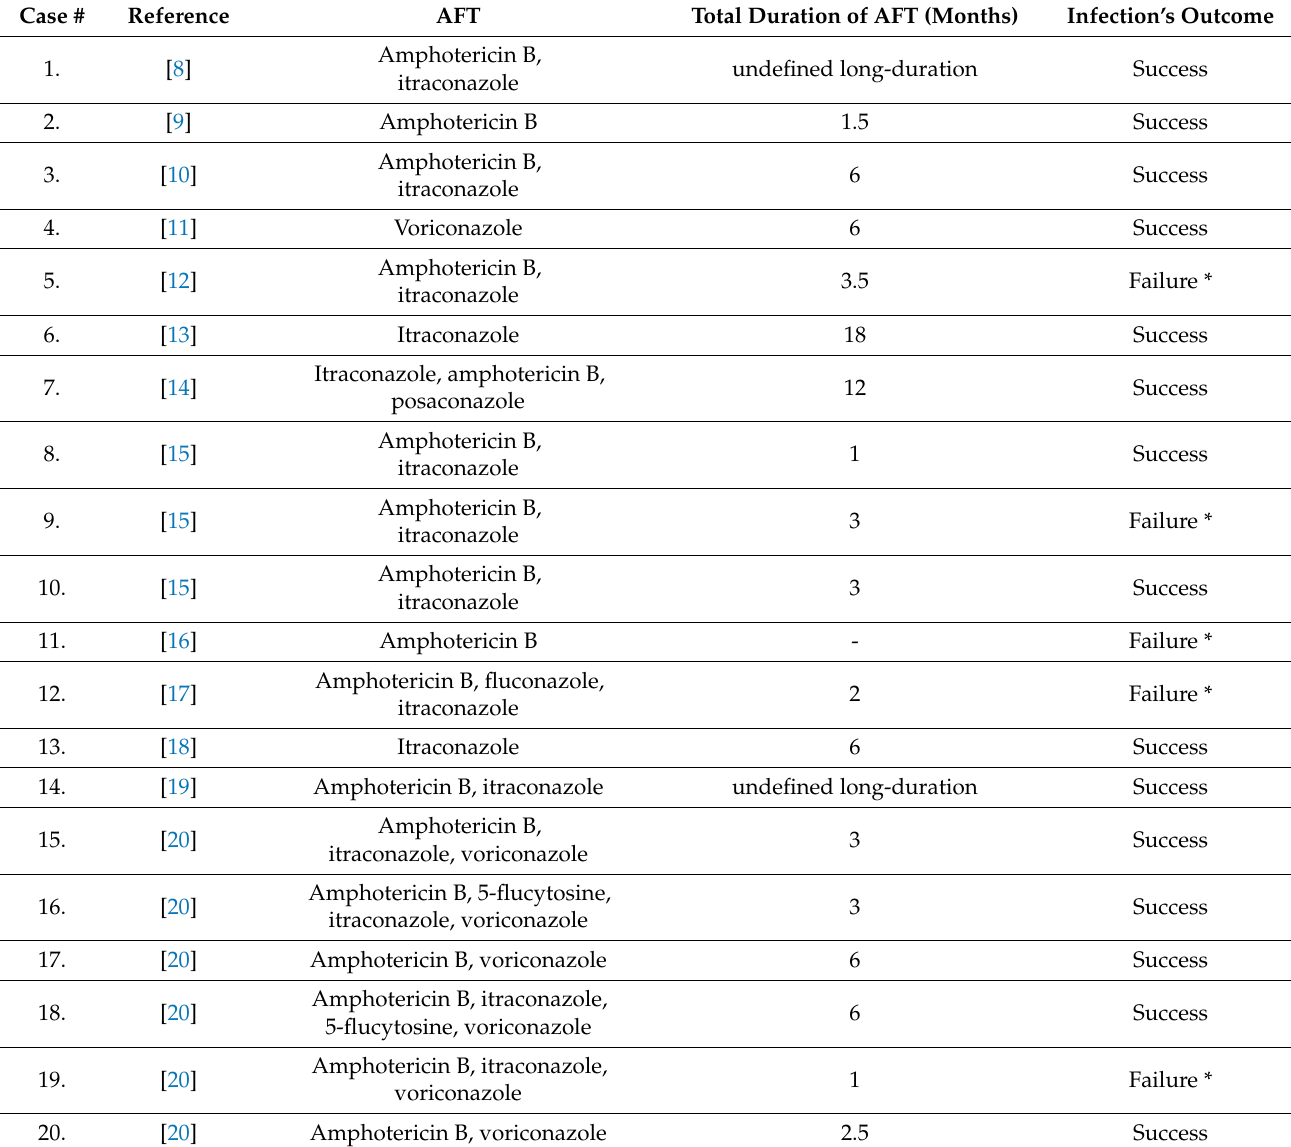
Table 2. Therapeutic management of osteomyelitis due to Aspergillus spp. Antifungal treatment (AFT), duration of AFT, and infection’s outcome are presented. (*): death as a result of